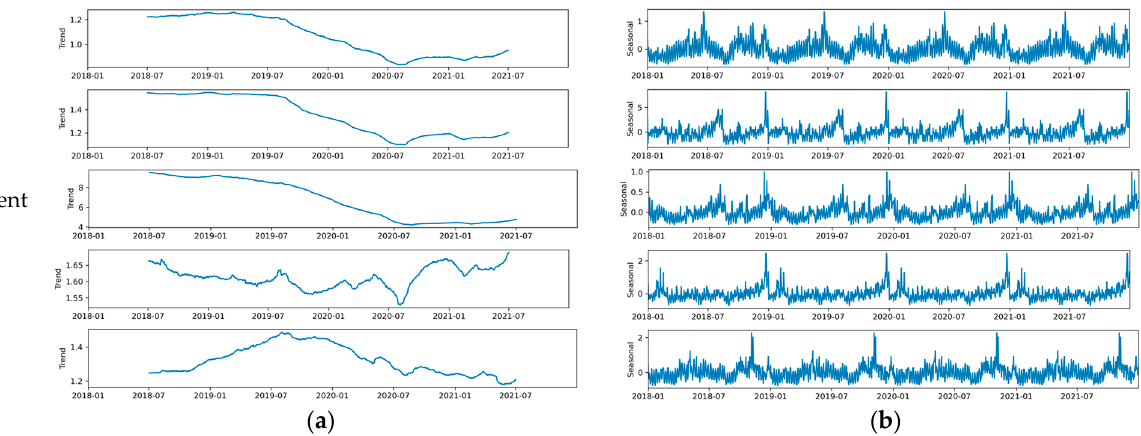
Figure 1. Breakdown of each retail category’s sales: ( a ) trend analysis; ( b ) seasonality analysis. Therefore, both naïve seasonal ETS and HW additive ETS models were selected for the fashion and f&b retail categories, the HW additive ETS model for the entertainment retail category and the naïve seasonal ETS model for the cosmetics and sport retail categories. Table 4 presents the forecasting models used for each retail category. Table 4. Forecasting models for each retail categories.